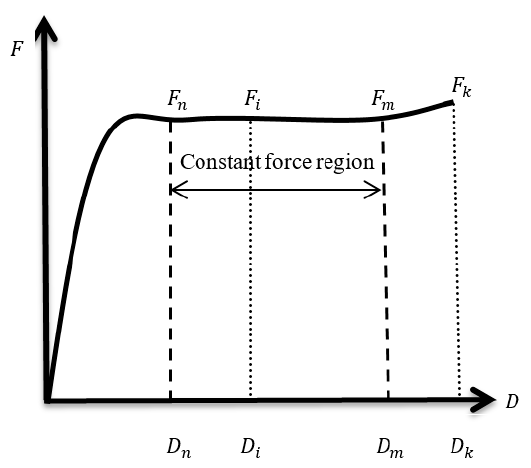
Figure 3. The force-to-displacement curve of a typical constant force component.